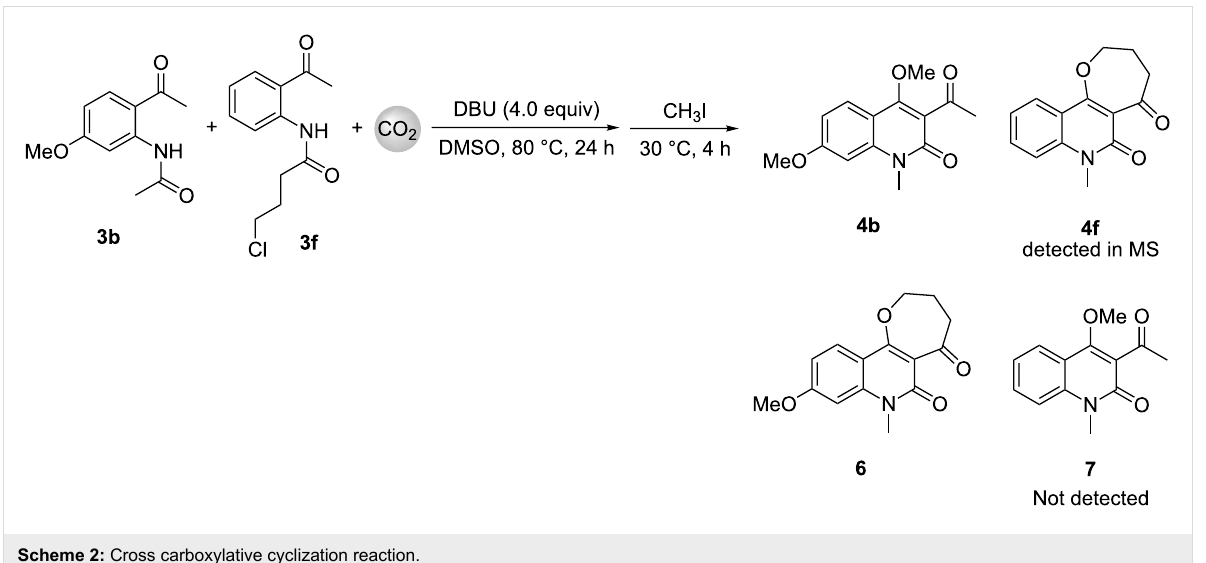
Scheme 2: Cross carboxylative cyclization